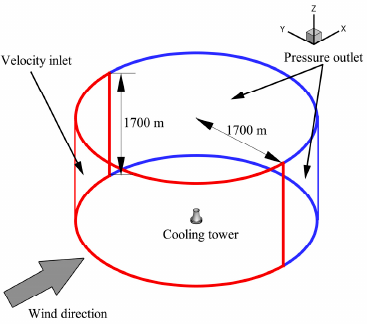
Figure 3. Computational field and boundary conditions.